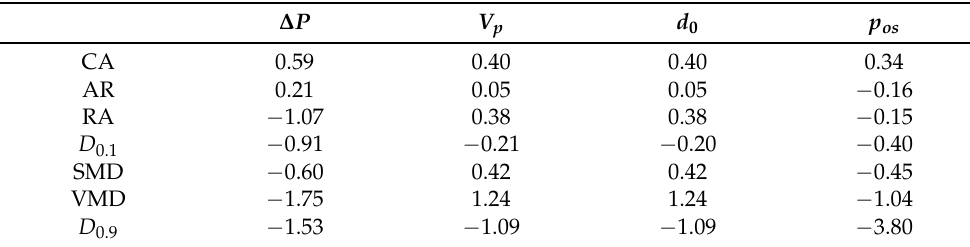
Table 5. Estimated regression operational process planner (OPP) coefficients ˆ γ .